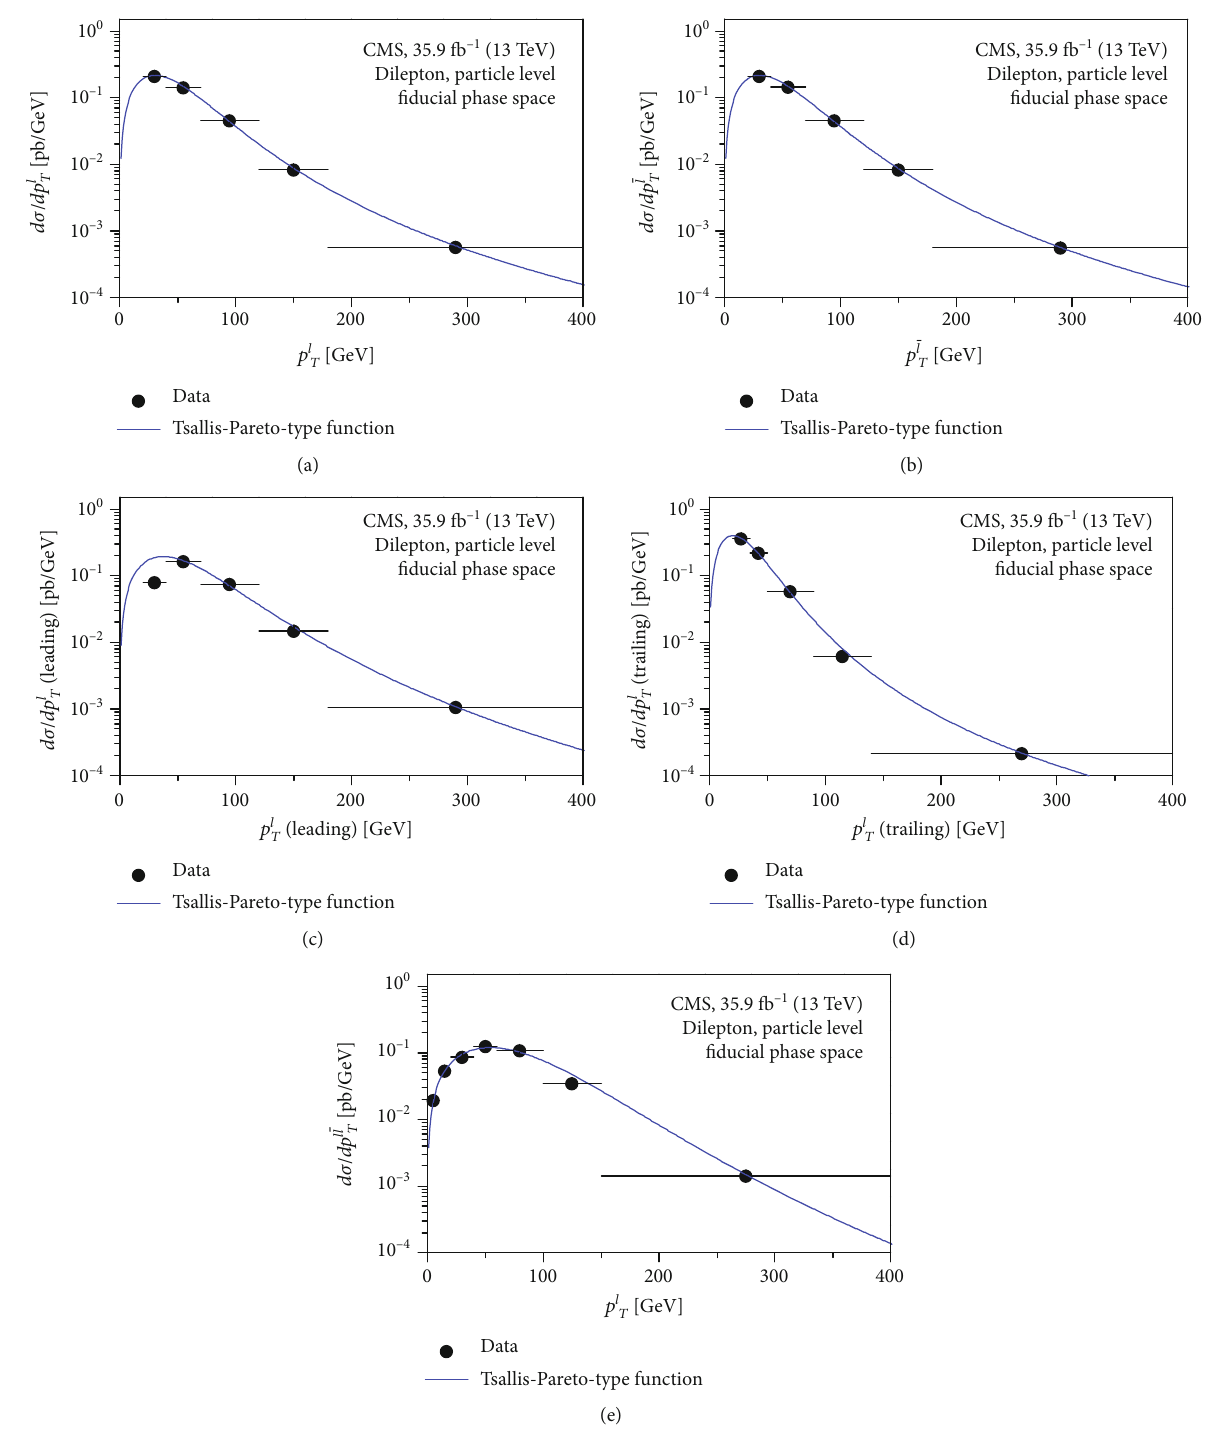
p (cid:1) l T ), (b) the antilepton ( T ), (c)